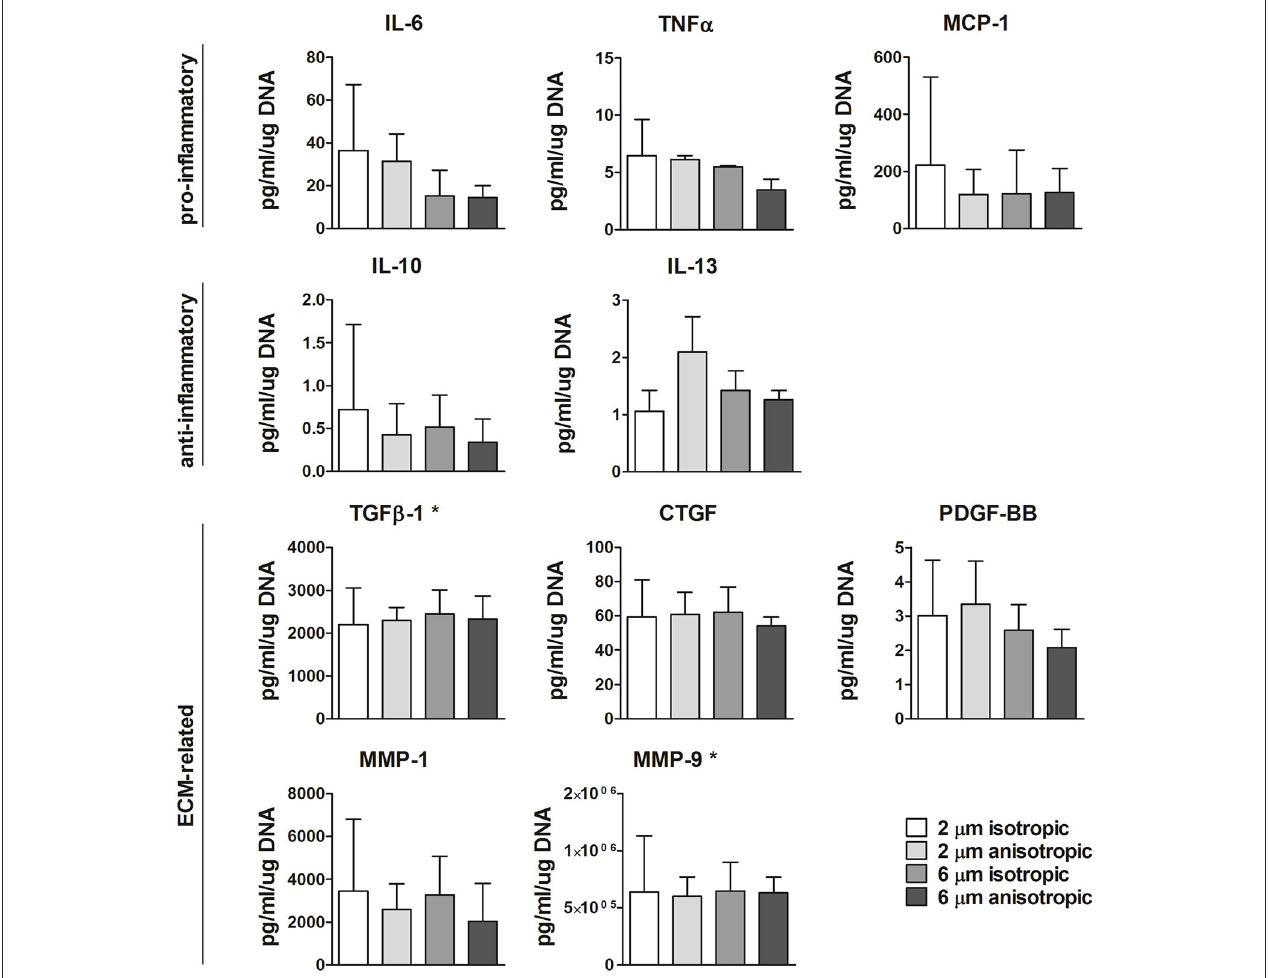
FIGURE 6 | Protein secretion. Secretion levels of pro- or anti-inflammtory, and ECM-related proteins for macrophages cultured up to day 8 on scaffolds with different microarchitectures. *Values were extrapolated beyond the standard range. N ≥ 3/group/time